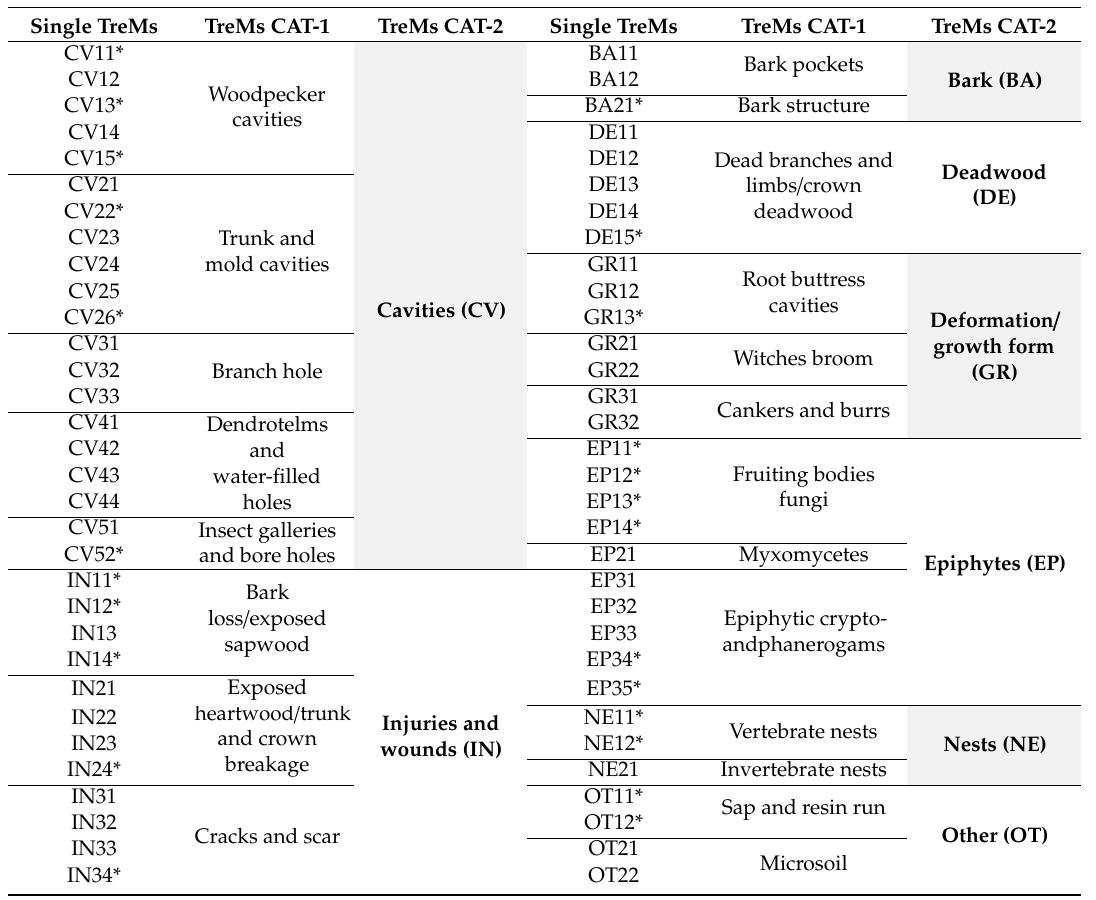
Table 1. Tree-related Microhabitat (TreM) hierarchical classification (source: Kraus et al. 2016). Level 4, named TreMs SUM, is not reported here because it is not dependent on the type of TreMs but only on their occurrence on the trees, often including di ff erent TreMs types. Microhabitats that are not encountered in the forest are marked with